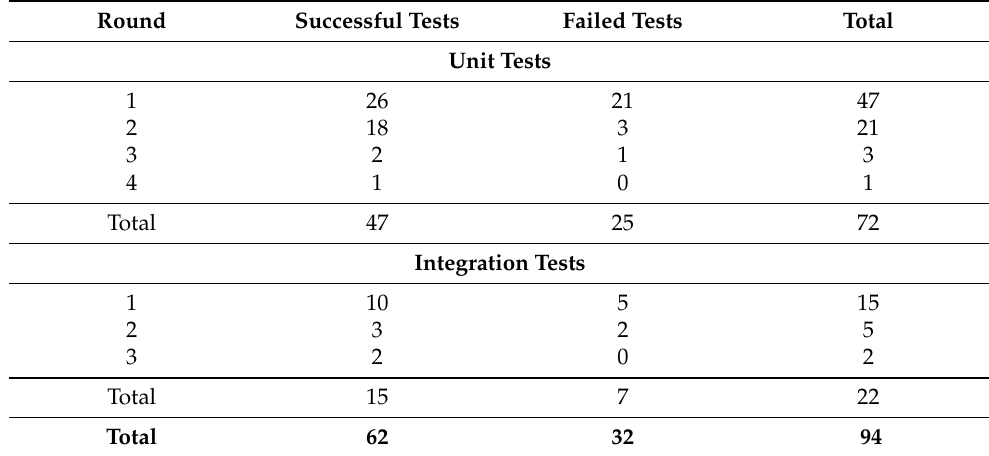
Table 1. Table of tests performed during the first iteration. Round Successful Tests Failed Tests Total Unit